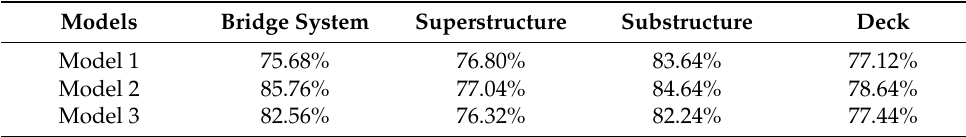
Table 3. Prediction accuracy of bridge units and system for each